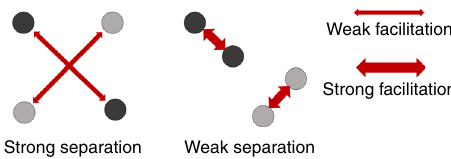
Fig. 6 Relationship between pattern separation of context representations and CTD retrieval. Stronger hippocampal separation of contexts sharing the same CTD may lead to more distinct neural coding of contexts (indicated by the distance between dots of the same color), but weaker facilitation from the other context in supporting retrieval of the associated CTD (indicated by the thickness of the red